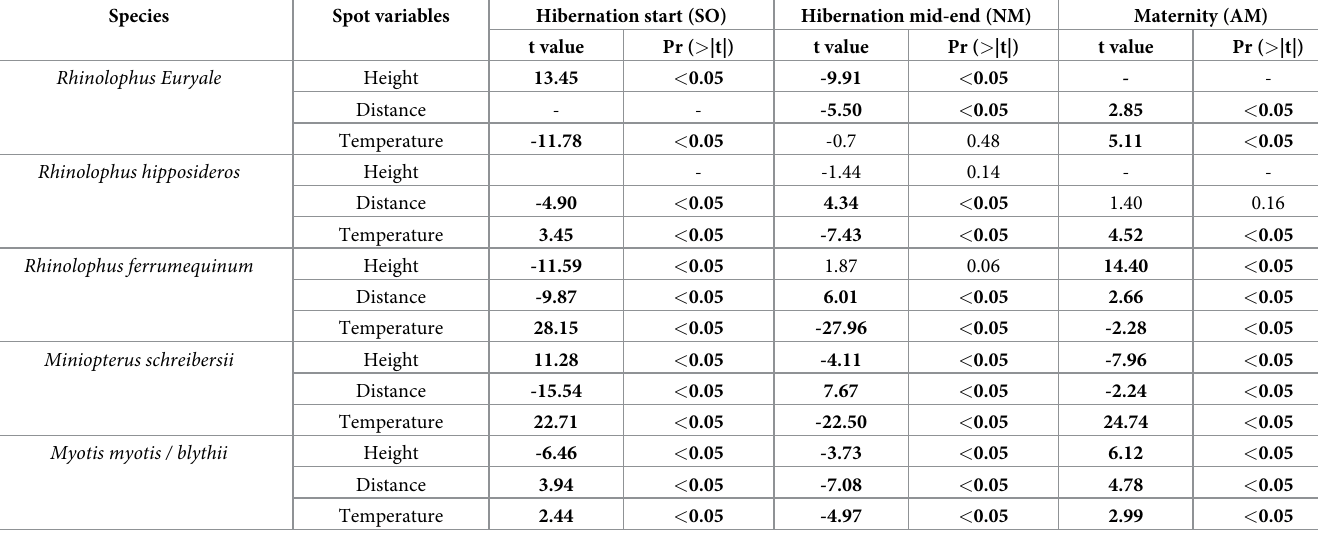
Bold = statistically significant results.